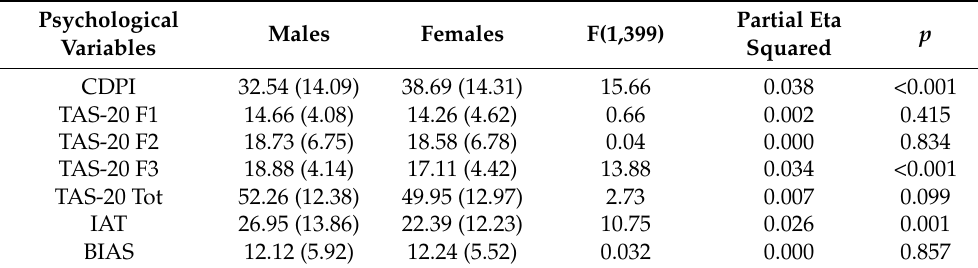
Table 3. Means, standard deviation, F, and partial eta squared of boys’ and girls’ scores on CDPI, TAS-20, IAT, and BIAS.